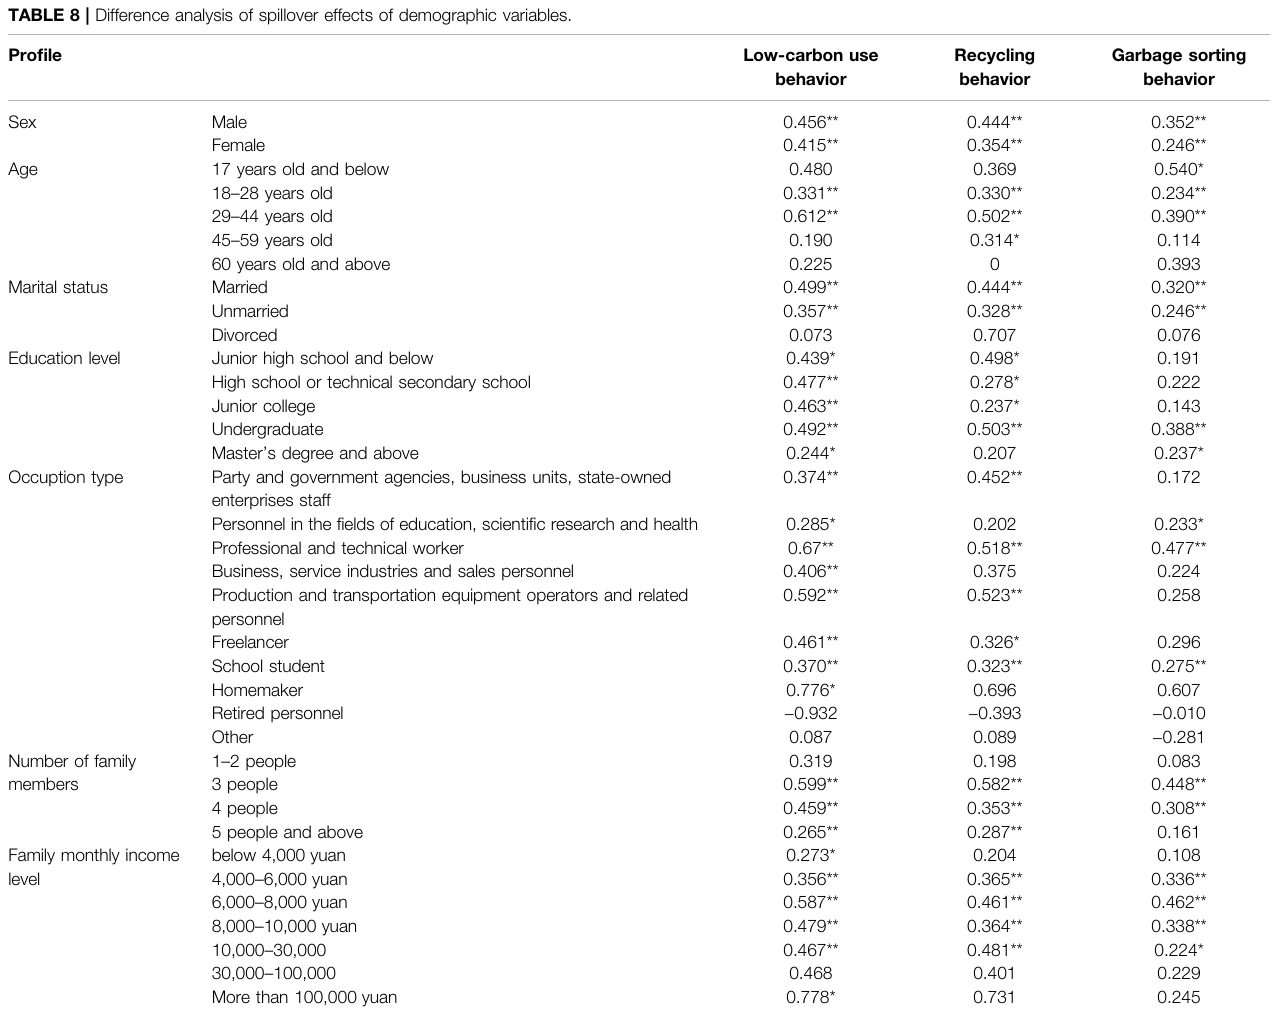
TABLE 8 | Difference analysis of spillover effects of demographic variables. Pro fi